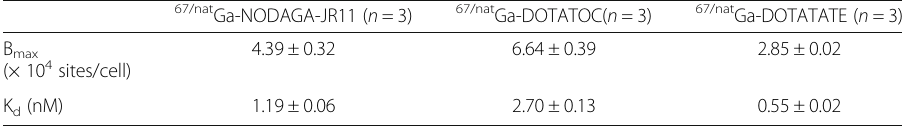
Table 2 Saturation binding results for respective radiotracers with ZR-75-1